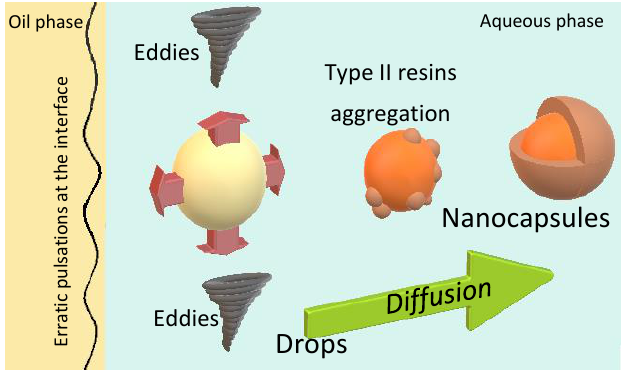
Figure 1. Schematic representation of the interfacial turbulence mechanism for nanocapsule formation based on the nanoprecipitation method also called solvent displacement.